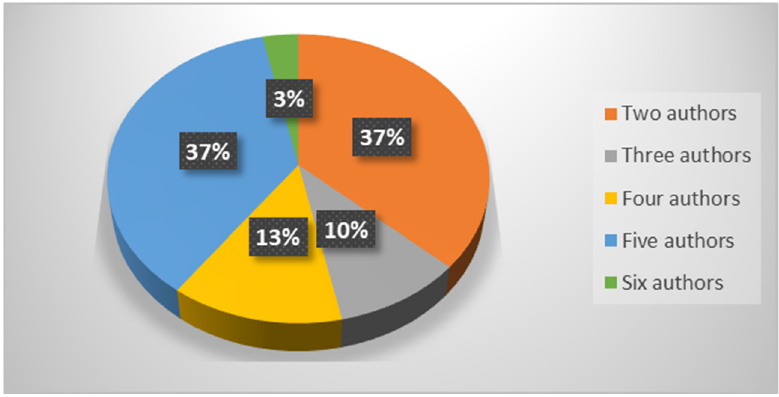
Figure 7. Number of author contributions for articles .